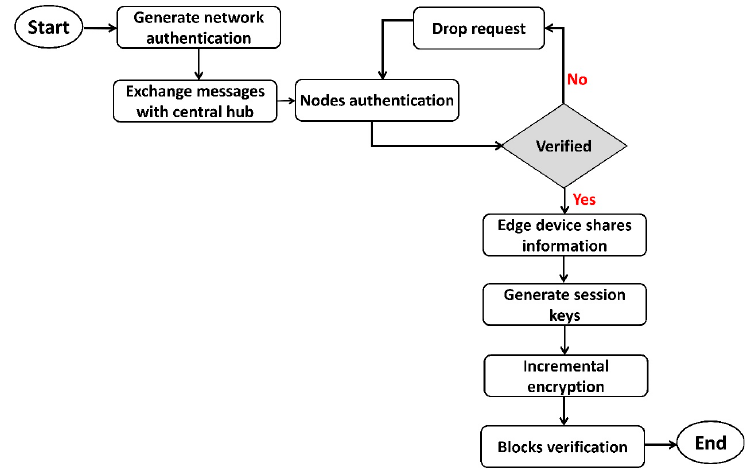
Figure 3. Flowchart of the proposed security algorithm using authentic methods.